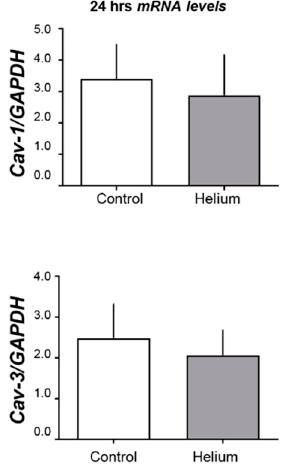
Figure 4. Cav ‐ 1 and Cav ‐ 3 mRNA levels. Histogram shows the results of the real ‐ time PCR experiments of mice whole ‐ heart tissue. Upper panel is Cav ‐ 1 over GAPDH. and lower panel is Cav ‐ 3 over GAPDH ( n = 5 for control and n = 6 for helium). No significant changes were observed, suggesting that the increase of Cav ‐ 3 in exosomes from PFP at this time point is not due to higher levels of Cav ‐ 3 gene expression but through a different mechanism, such as the direct release of Cav ‐ 3 from plasma membranes.